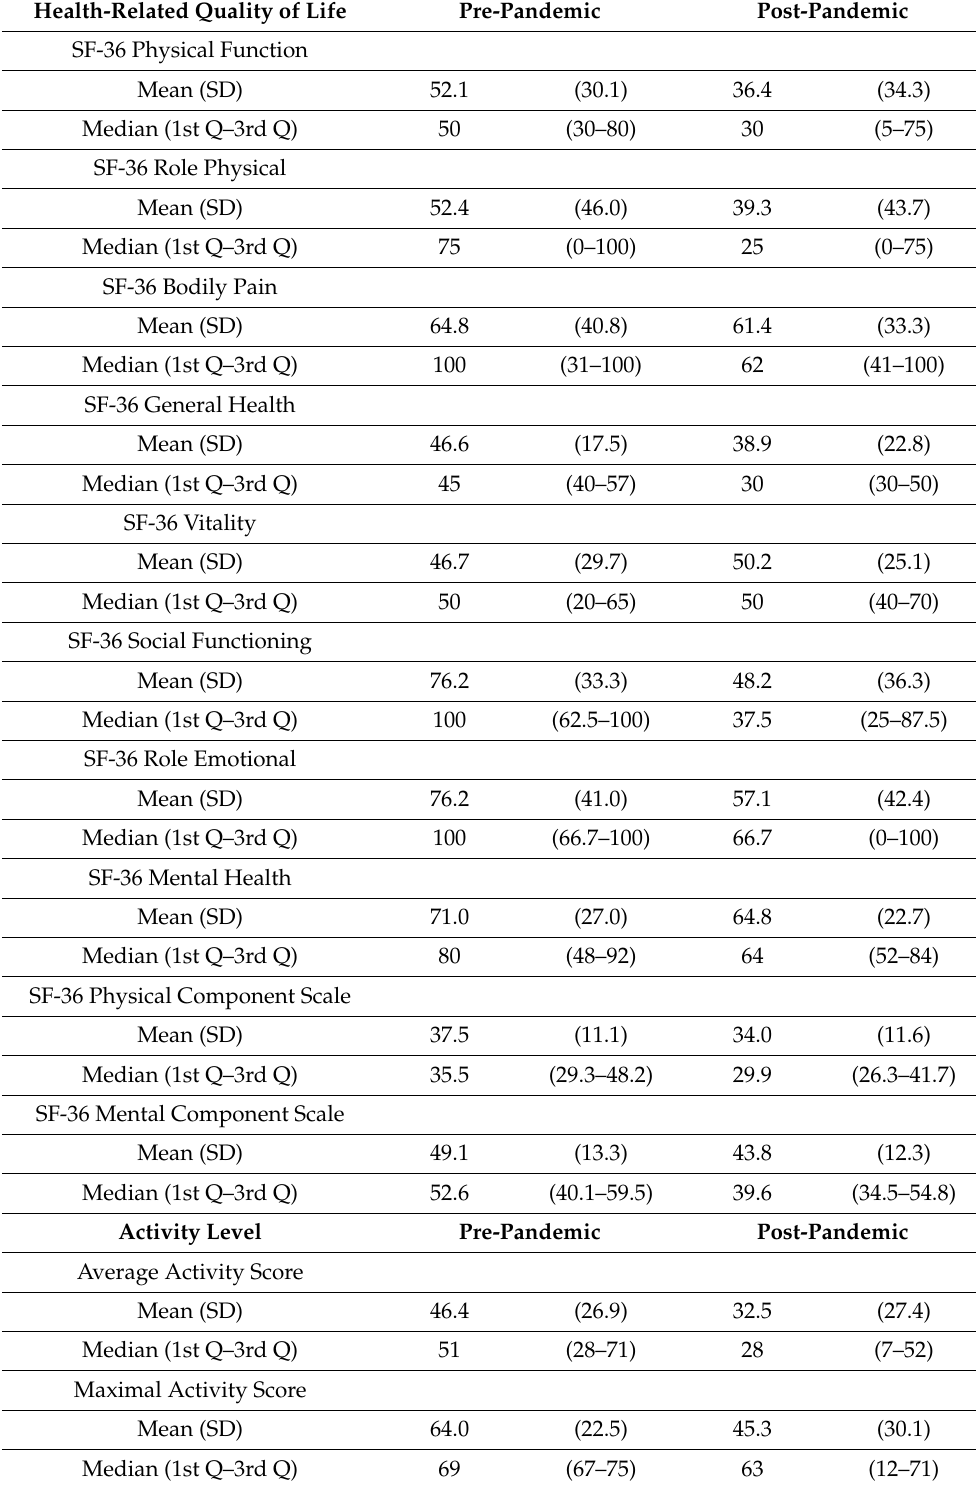
Table 3. Health-related quality of life and physical activity level of hemodialysis